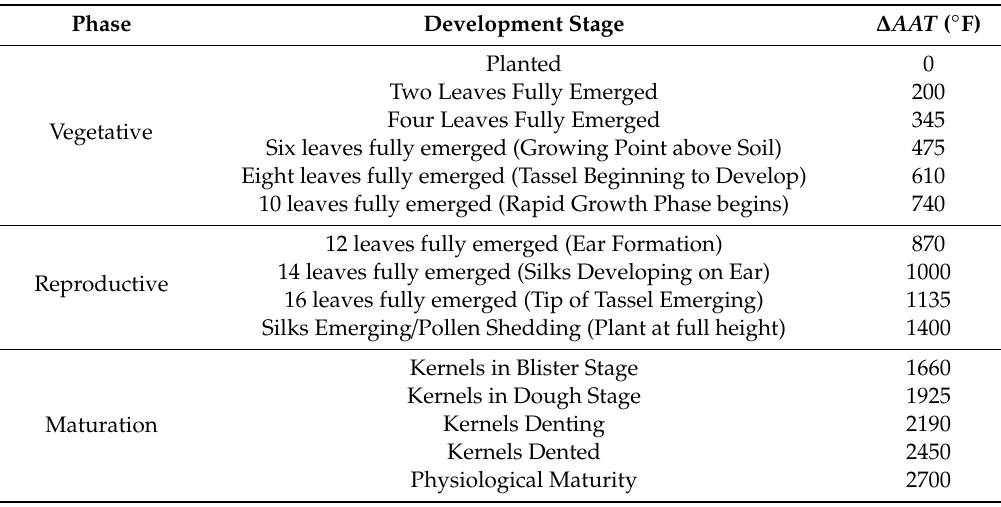
Table 1. Corn growth stages and growing degree